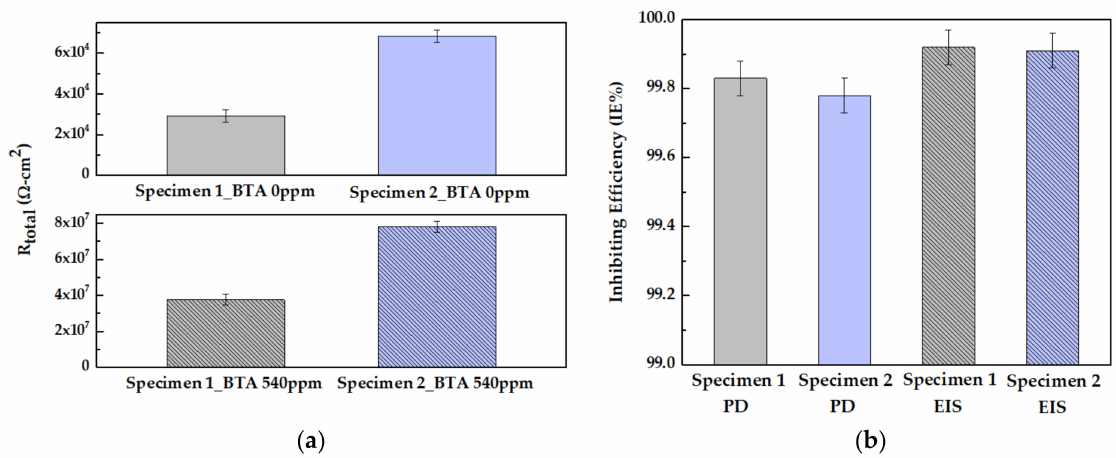
Figure 7. ( a ) The value of the total resistance of copper as a function of BTA; ( b ) The inhibiting efficiency ( IE% ) of copper as a function of BTA from potentiodynamic (PD) polarization curve and